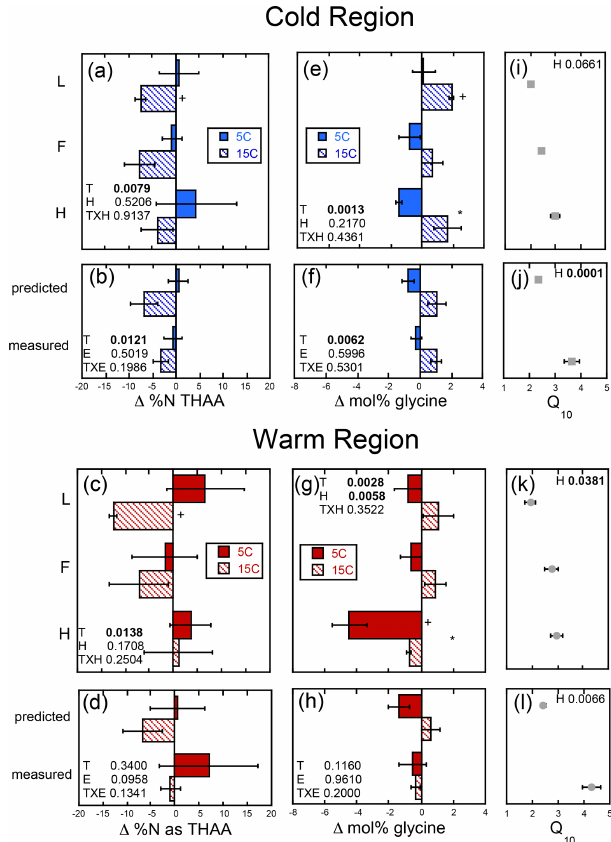
Figure 6. The change in soil %N as total hydrolyzable amino acid ( (cid:49) %N as THAAs) and mole percent glycine ( (cid:49) mol% glycine) given as the difference between the absolute final minus initial val- ues for the soils incubated as individual horizons in isolation from each other (upper panels labeled by horizon: L , F , and H ) and those calculated as whole profile values based upon those same isolated horizon results (predicted) and those measured directly from the in- cubation of whole organic profiles (measured). These results are given for both the cold (a, b, e, f) and warm regions (c, d, g, h) , and the corresponding temperature sensitivity of the total cumula- tive respiration for the total incubation period ( Q 10 ; cold region, i and j ; warm region, k and l ) taken from Podrebarac et al. (2016) are provided for reference. All values provided are the mean of the three sites ± the standard error with a significant change from 0 denoted by symbol “ + ”. Any significant ( α ≤ 0 . 05) effect of temperature ( T ), horizon ( H ), or experiment ( E ) or interaction term ( T × H or T × E ) is denoted in bold. A significant effect of temperature within horizon or within experiment is denoted by an